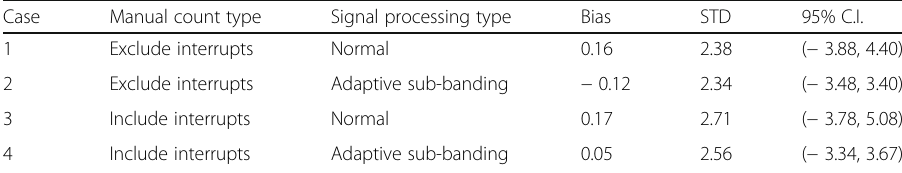
Table 2 Table highlighting bias, standard deviation, and 95% confidence intervals for the different test